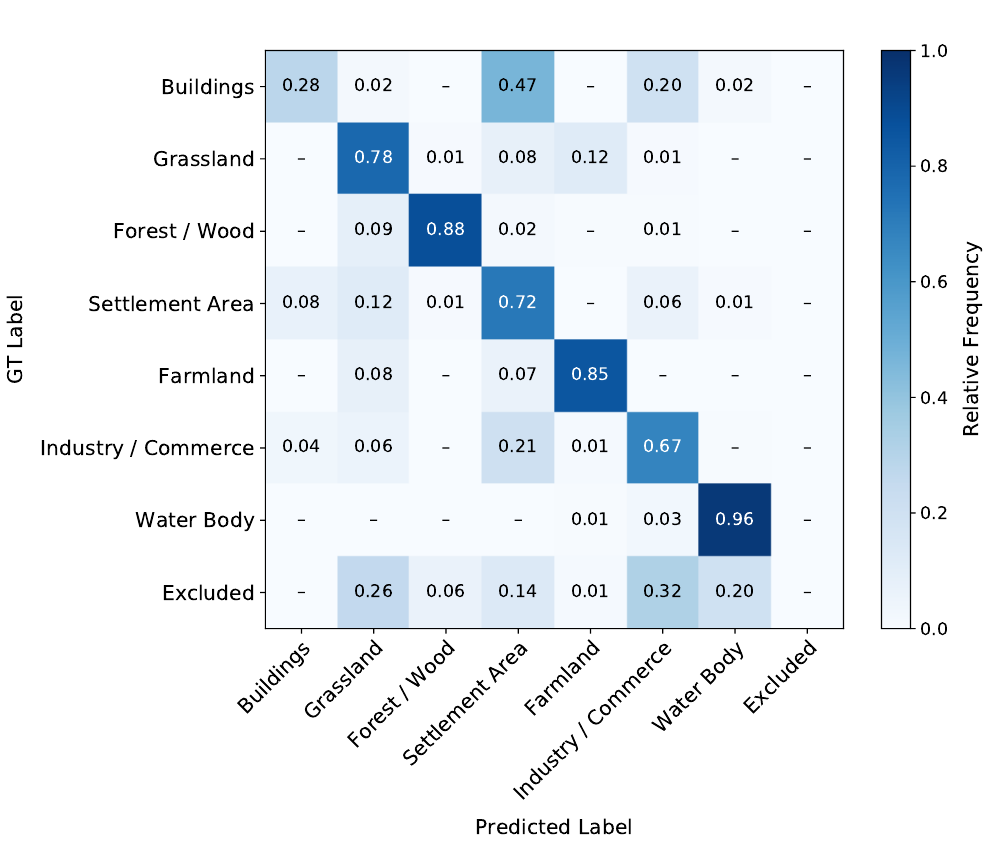
Figure A1. Normalized confusion matrix for the best-scoring ensemble of LSTM V models. The prediction is performed on the six sequences built from the 2018 data using the introduced voting scheme and compared to the GT. Table A1. Percentage of pixels in each confidence category per class (pixel class determined by the classification). Classification of the full AOI with six time sequences from 2018 by the LSTM F . As explained in Section 4.2, high confidence ≡ unison vote, medium confidence ≡ absolute majority, and low confidence ≡ no majority in the six-fold voting